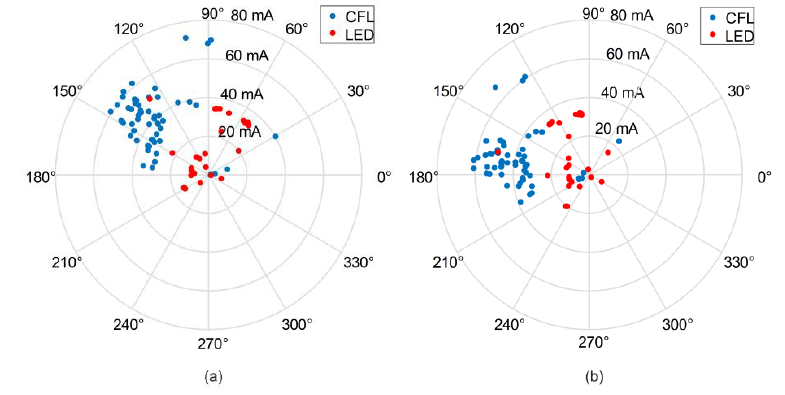
Figure 2. Fifth harmonic current emission under: ( a ) sinusoidal supply voltage; ( b ) flat-top supply voltage.